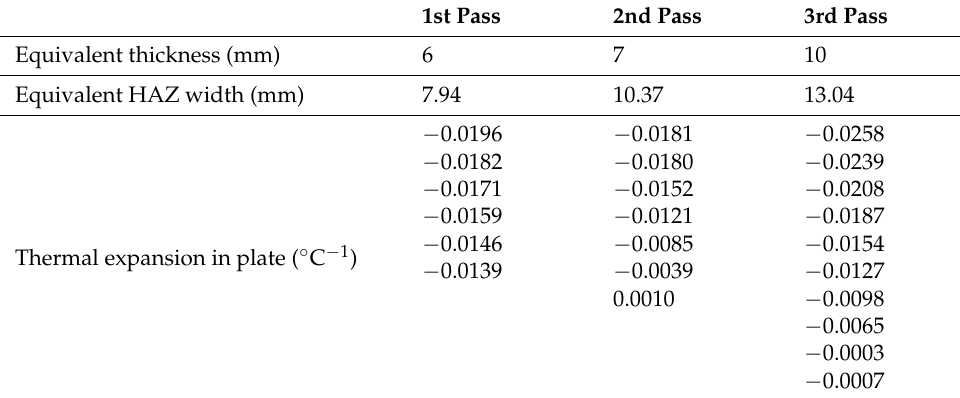
Figure 12. Equivalent HAZ width and equivalent thickness for each pass. Table 3. Parameters of each pass for layered shell-element welding analysis method.